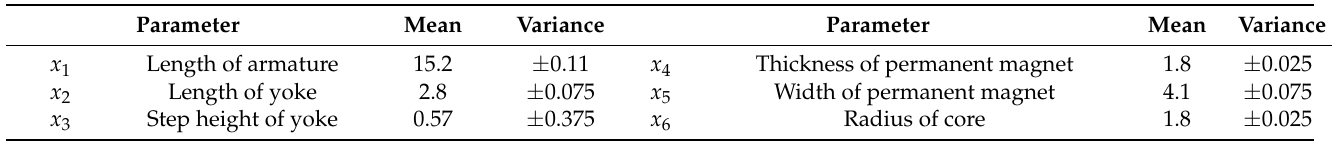
Table 3. Critical MP parameters.